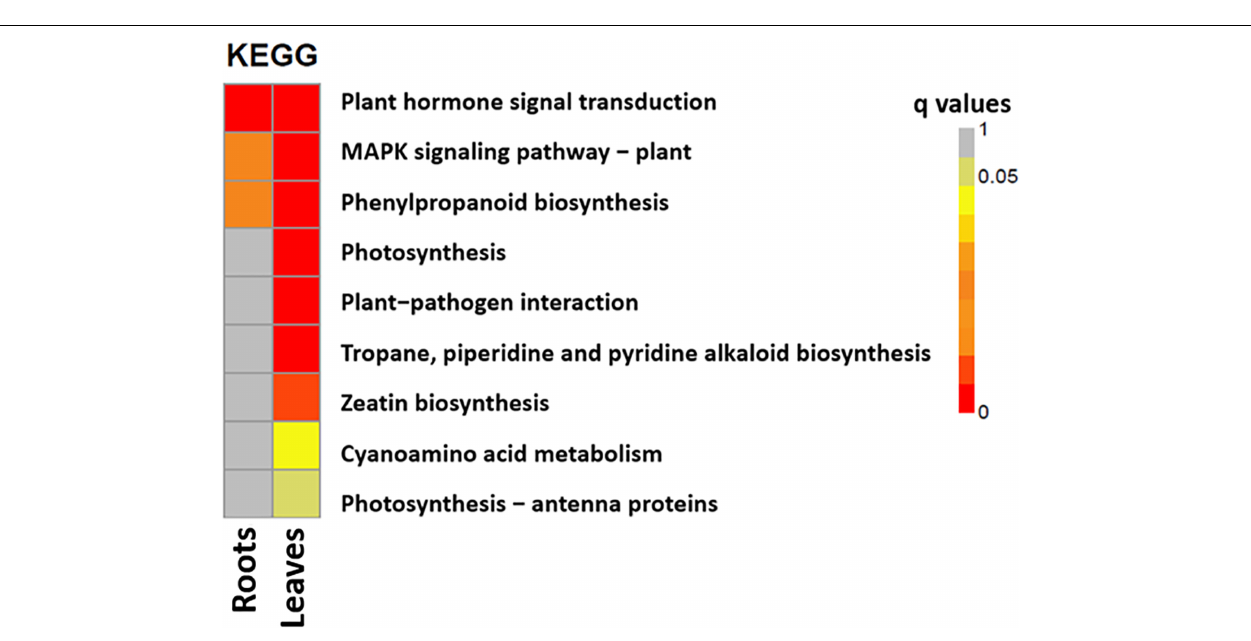
( Figure 8C ). Interestingly, the levels of monolignols